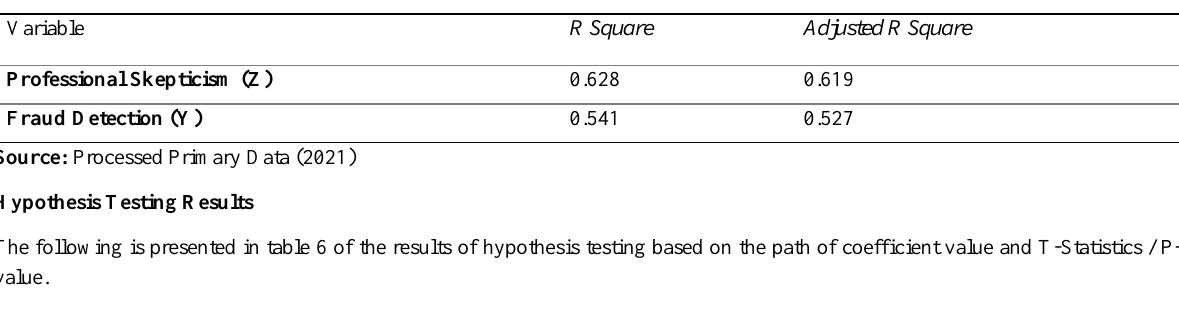
Table 4: Result of the Coefficient of